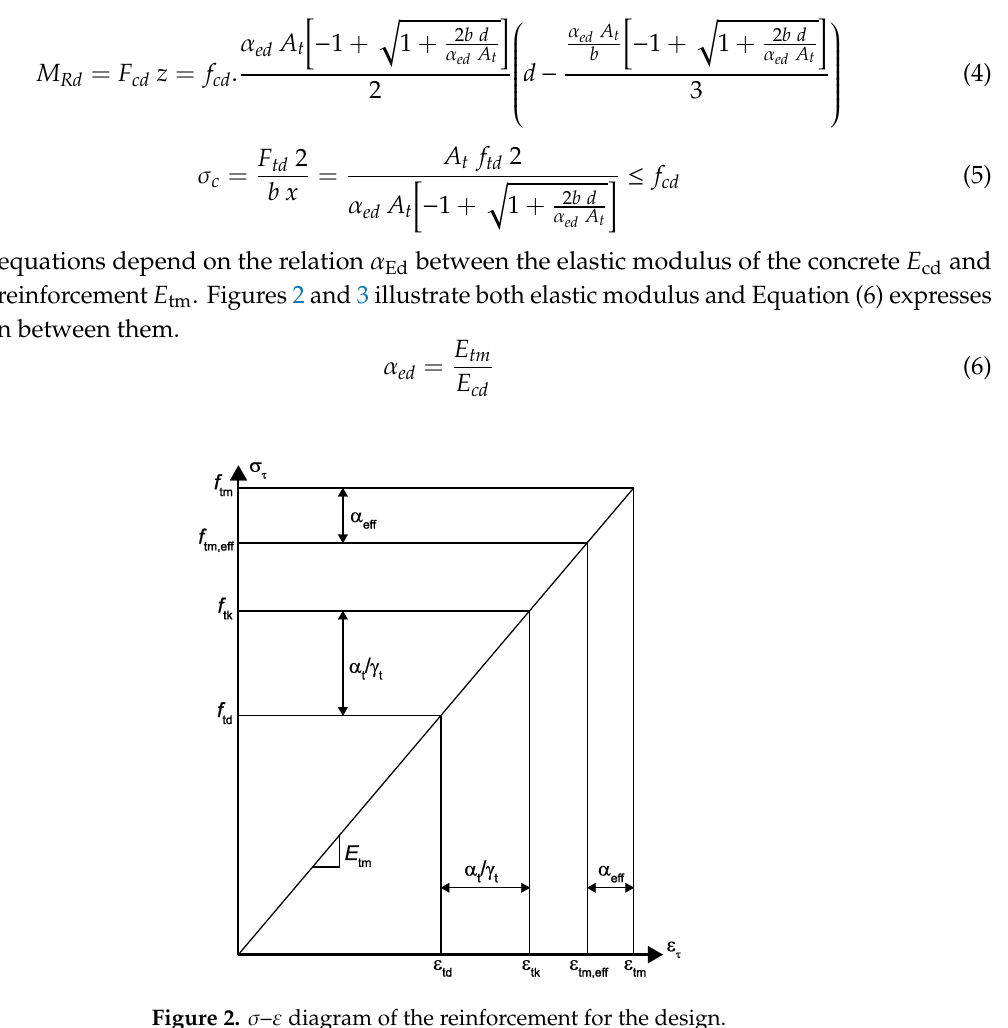
Figure 2. σ – ε diagram of the reinforcement for the design.